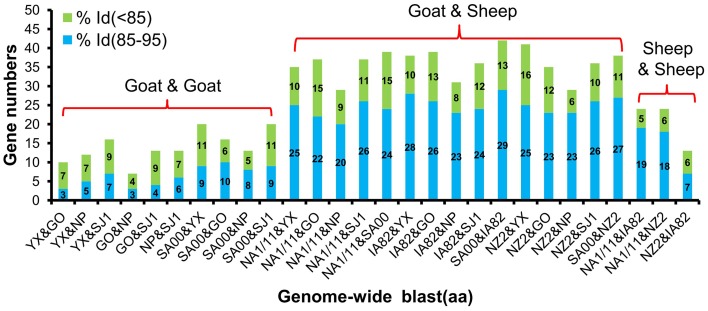
Gene numbers of below 95% and 85–95% amino acid identity compared with each other among eight ORFVs.